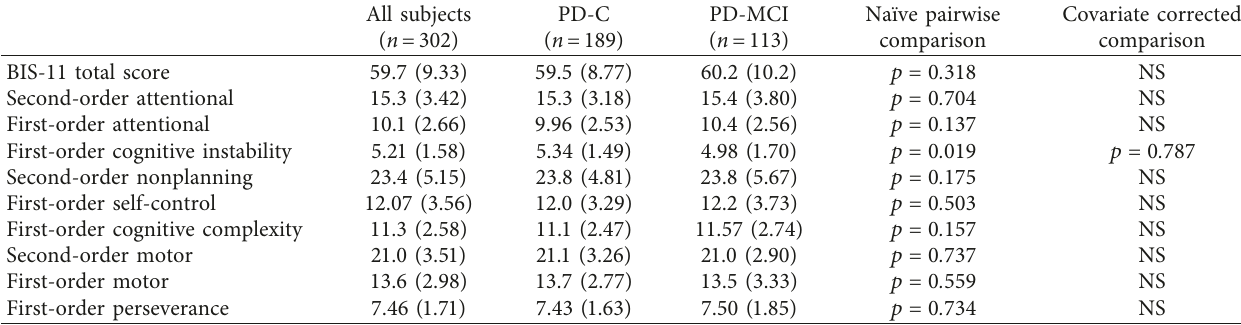
Table 3: Total BIS-11 and first- and second-order scores in the overall cohort and PD-C and PD-MCI groups.